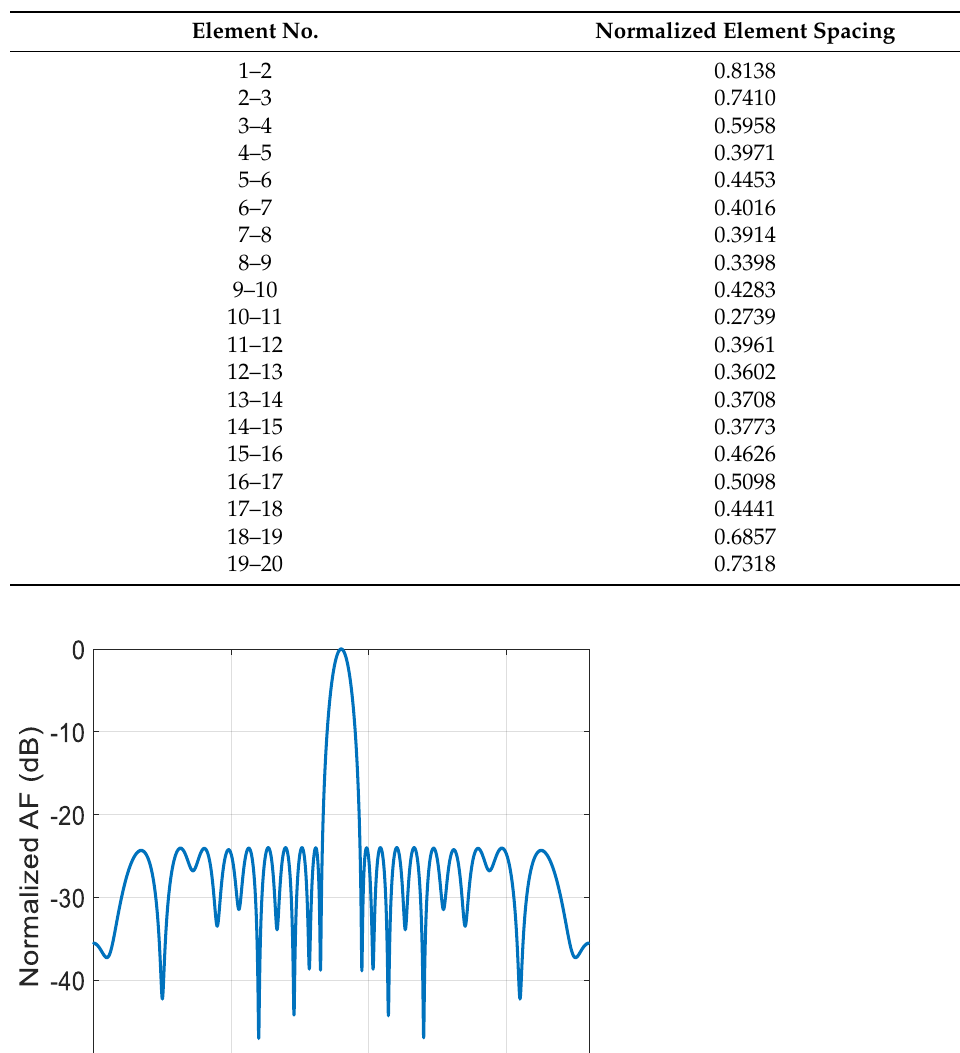
Table 4. The best normalized value of inter-element spacing with respect to the wavelength ( λ ) using FKE.